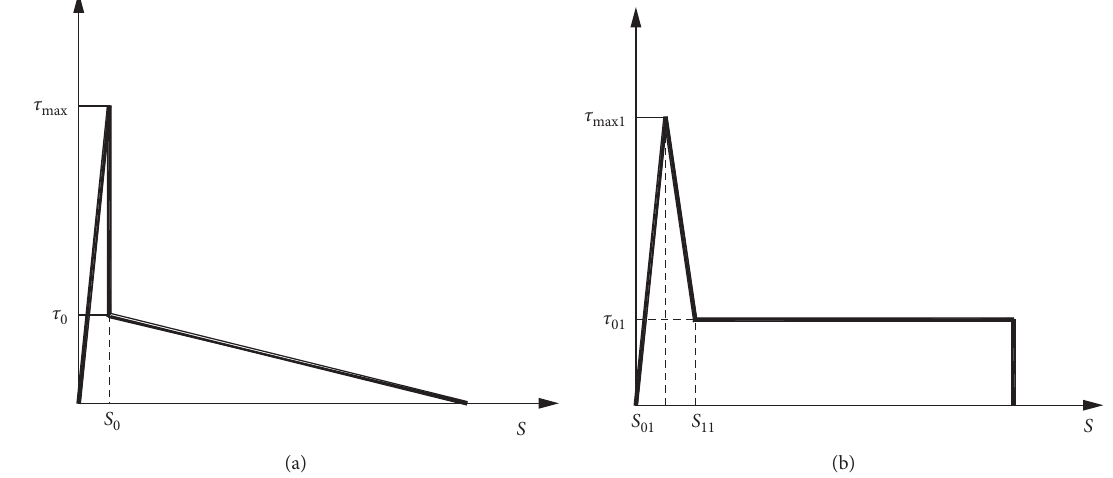
Figure 10: The bonding stress-slip constitutive model of the (a) nonanchored area and (b) anchored